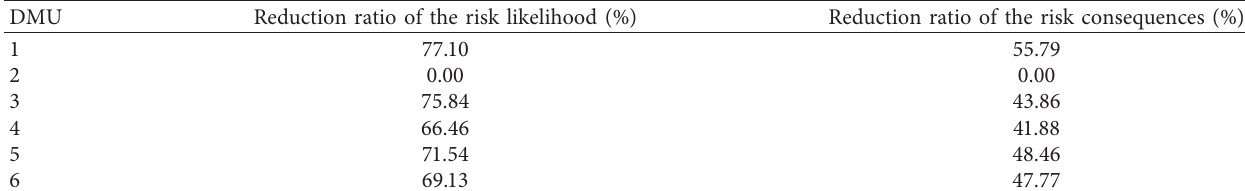
Table 5: Risk reduction degree of